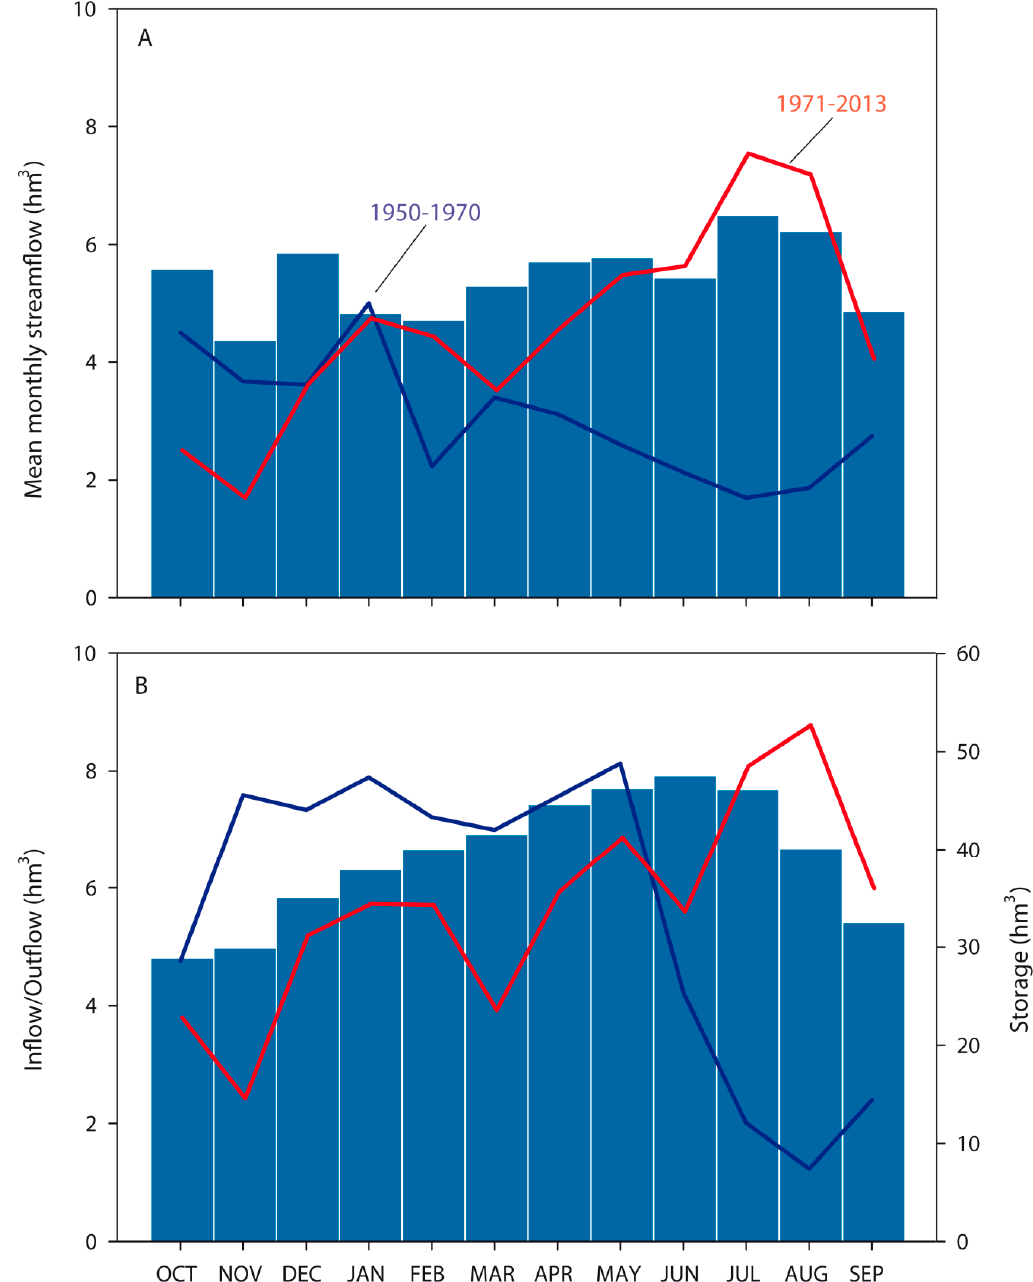
Figure 3. ( A ) Average river regimes in Boadella gauge station: blue bars: (1950–2013), blue line (1950–1970), and red line (1971–2013). ( B ) Average monthly values of inflows (blue), outflows (red), and storages (blue bars) in the reservoir of Boadella between 1971 and 2013.